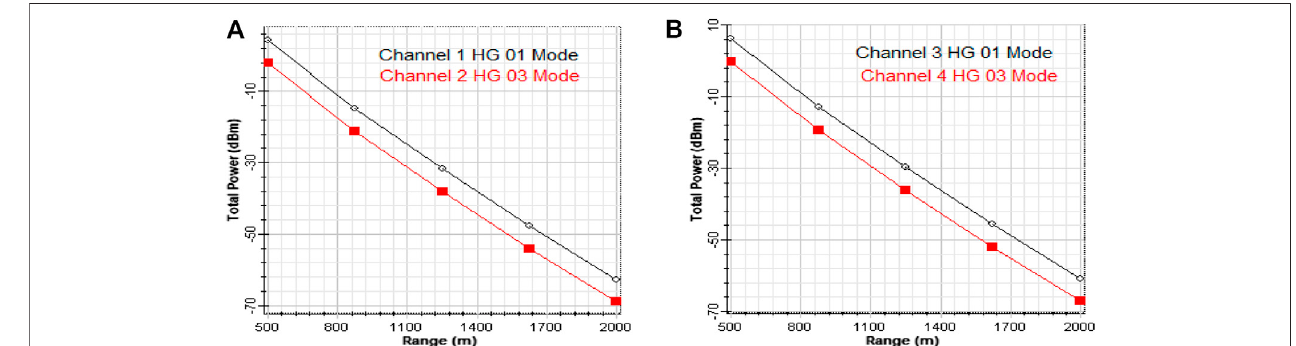
FIGURE 11 | Signal power plots for (A) 1931. THz channel and (B) 193.2 THz channel under heavy fog.